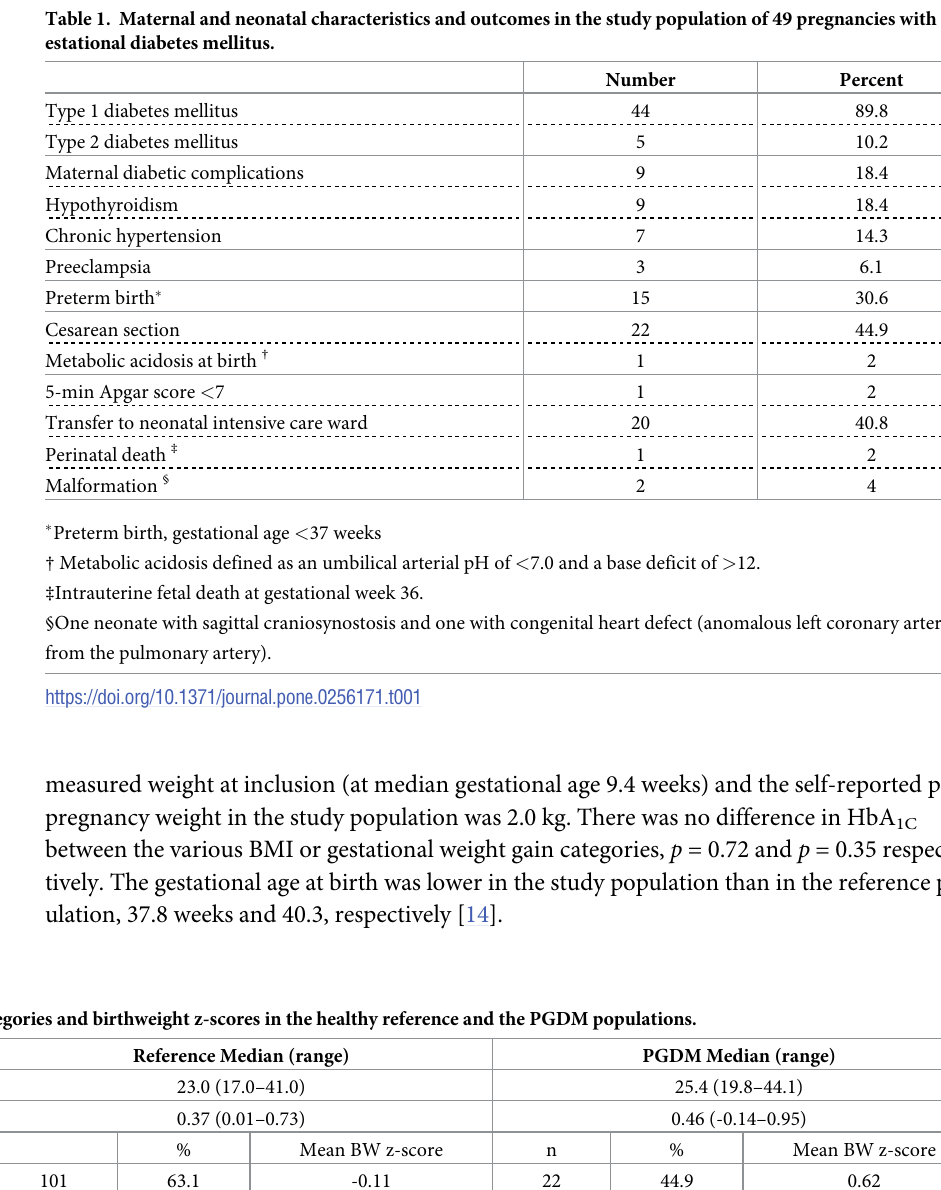
Table 2. Distribution of BMI and GWG categories and birthweight z-scores in the healthy reference and the PGDM populations. Reference Median